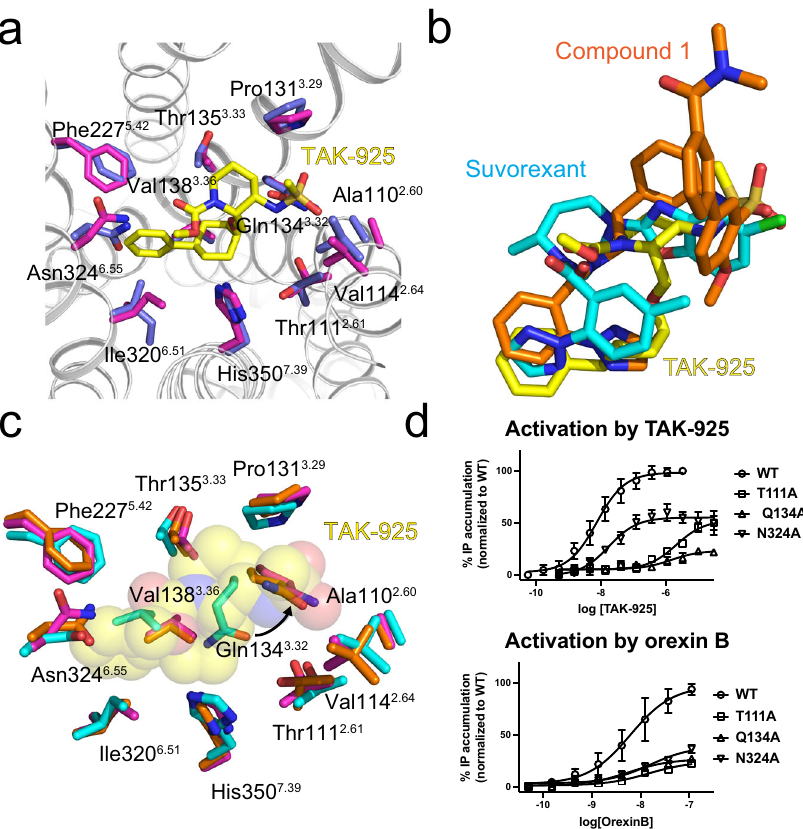
Fig. 2 Binding of TAK-925 to OX 2 R. a Overlay of contact residues (sticks with purple carbons for mG sqiN -coupled OX 2 R and sticks with blue carbons for G i1 -coupled OX 2 R) within 4 Å of TAK-925 (yellow carbons) when superimposing OX 2 R- mG sqiN and OX 2 R-G i1 . The OX 2 R backbone (silver) is from OX 2 R-mG sqiN . The hydrogen bond from Gln134 3.32 to TAK-925 ’ s sulfonamide is not shown because this residue is behind the ligand from this viewpoint (same as in Fig. 2c). b Overlay of TAK-925 (sticks with yellow carbons), Compound 1 (sticks with orange carbons) and suvorexant (sticks with cyan carbons) when superimposing the OX 2 R polypeptides from the OX 2 R-mG sqiN complex (this work), the OX 2 R-mini-G sqi complex (PDB 7L1V) and the antagonist-bound inactive conformation (PDB 4S0V). c Overlay of contact residues within 4 Å of TAK-925 when superimposing OX 2 R-mG sqiN (this work, magenta), OX 2 R-mini-G sqi /Compound 1 (PDB 7L1V, orange) and the suvorexant-bound inactive conformation of OX 2 R (PDB 4S0V, cyan). TAK-925 is shown as transparent spheres. d Stimulation of G q by OX 2 R wild type (WT) and mutants when bound to TAK-925 (top) and orexin B (bottom). Each data point represents an average from n ≥ 3 independent experiments (each performed in duplicate), where n is shown in Supplementary Table 2. Error bars are ±SD. Data were normalized to the WT E max and fi tted to the three-parameter model ‘ log(agonist) vs response ’ in GraphPad Prism 9. Source data are provided as a Source Data fi the S103T/A127T double mutant. Likewise, this result indicates that the allosteric pathway of activation for OX 1 R can be turned on by agonist binding at this site, and rules out the possibility that TAK-925 has minimal potency at OX 1 R due to differences in the allosteric transmission mechanism.